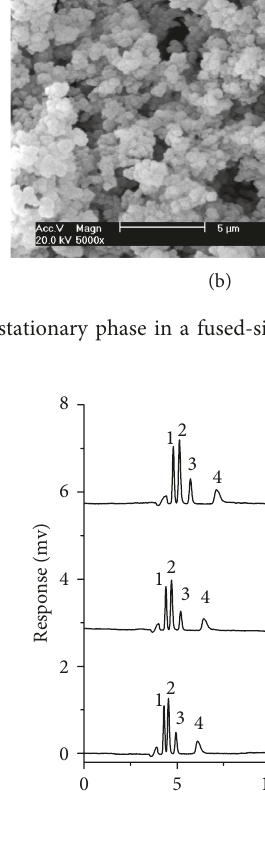
Figure 3: Effect of pH of buffer solution on separation of 5- nitroimidazole compounds. MIP monolith: 51cm column length; 30cm effective length. Electrochromatographic conditions: mobile phase, ACN/10mM sodium dihydrogen phosphate-disodium hydrogen phosphate buffer (30/70, v/v); voltage: +10kV; flow rate: 0.1ml/min; supplement pressure: 1000psi. 1MNZ, 2SNZ, 3TNZ, 4 ONZ, and 5 MB.